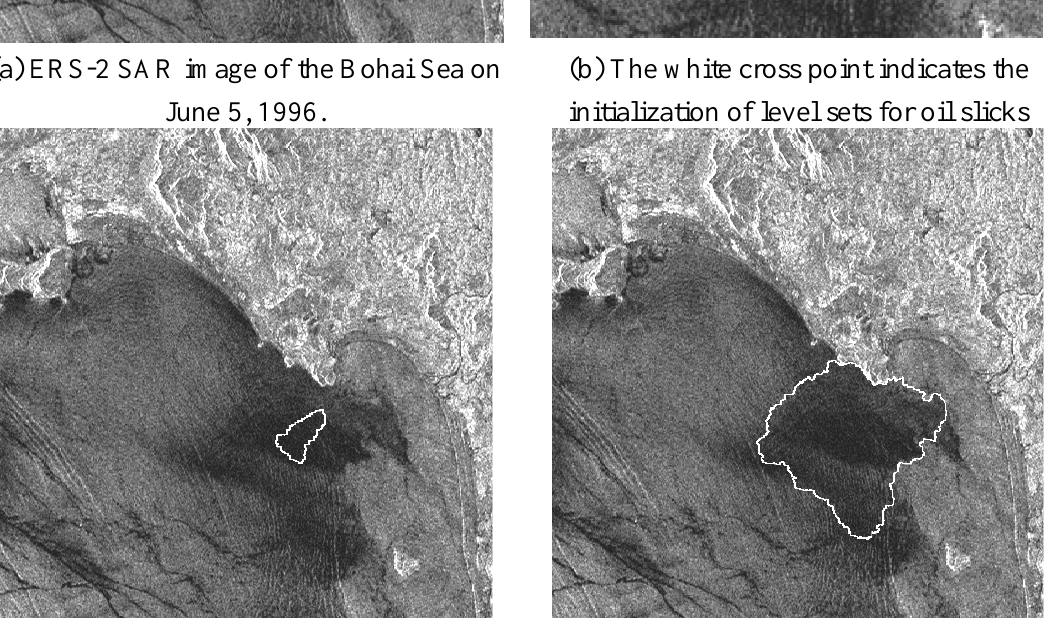
(c) An interface boundary expanding snapshot